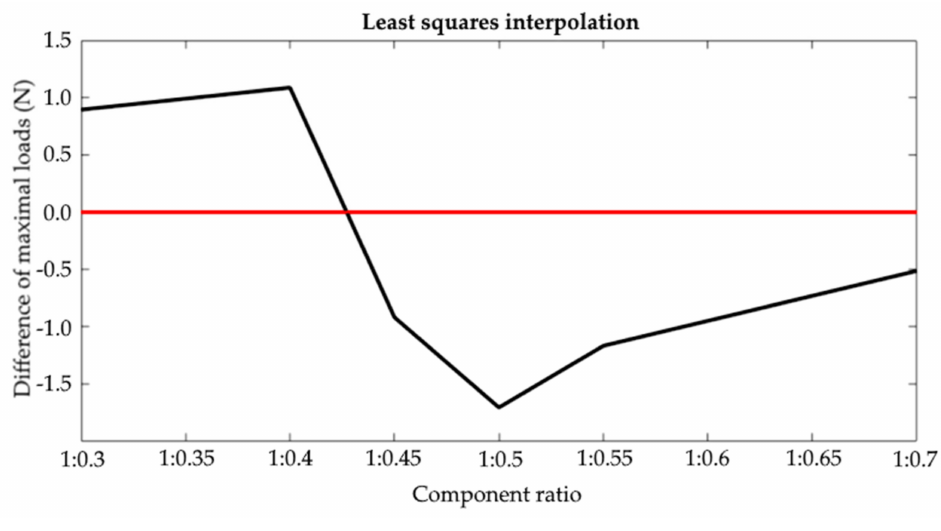
Figure 15. Least-squares interpolation.